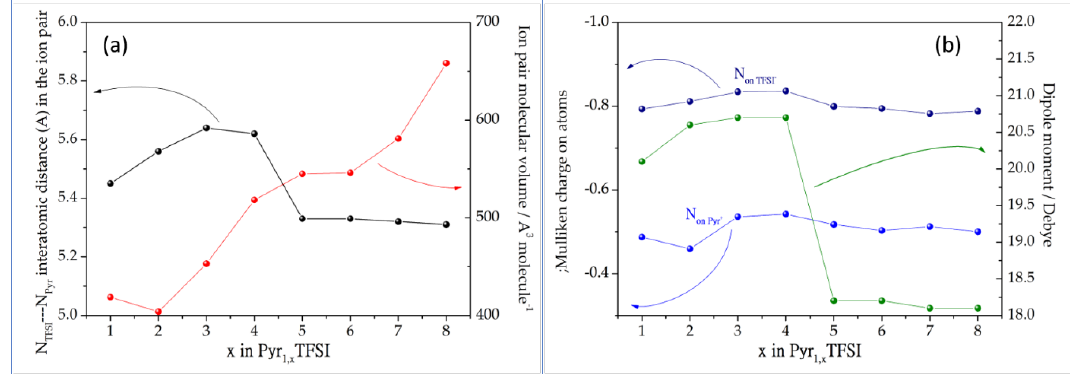
Figure 2. ( a ) Size of the ion pair and N–N interatomic distance in the ionic couple in function of the length of the pyrrolidinium later alkyl chain; ( b ) evolution of the Mulliken charges on the nitrogen atoms in the ionic couples in function of the length of the pyrrolidinium later alkyl chain in comparison with the dipole moment.